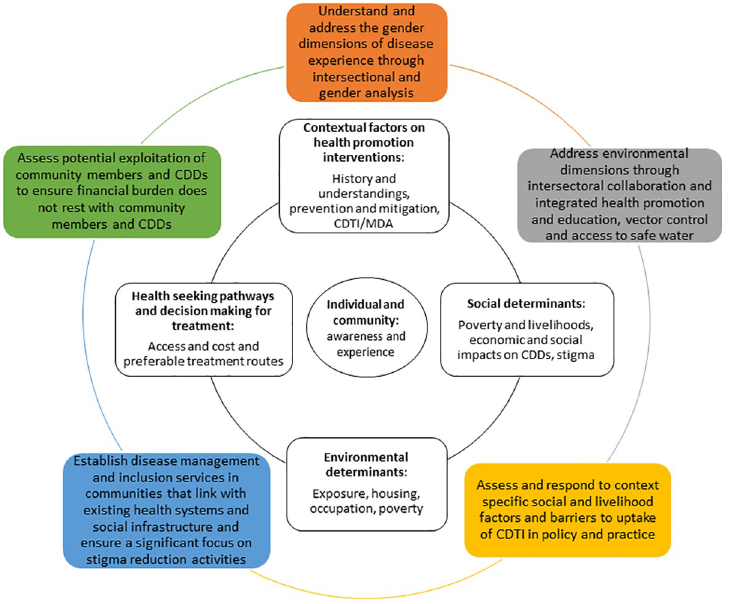
Fig 3. Results and Recommendations for onchocerciasis